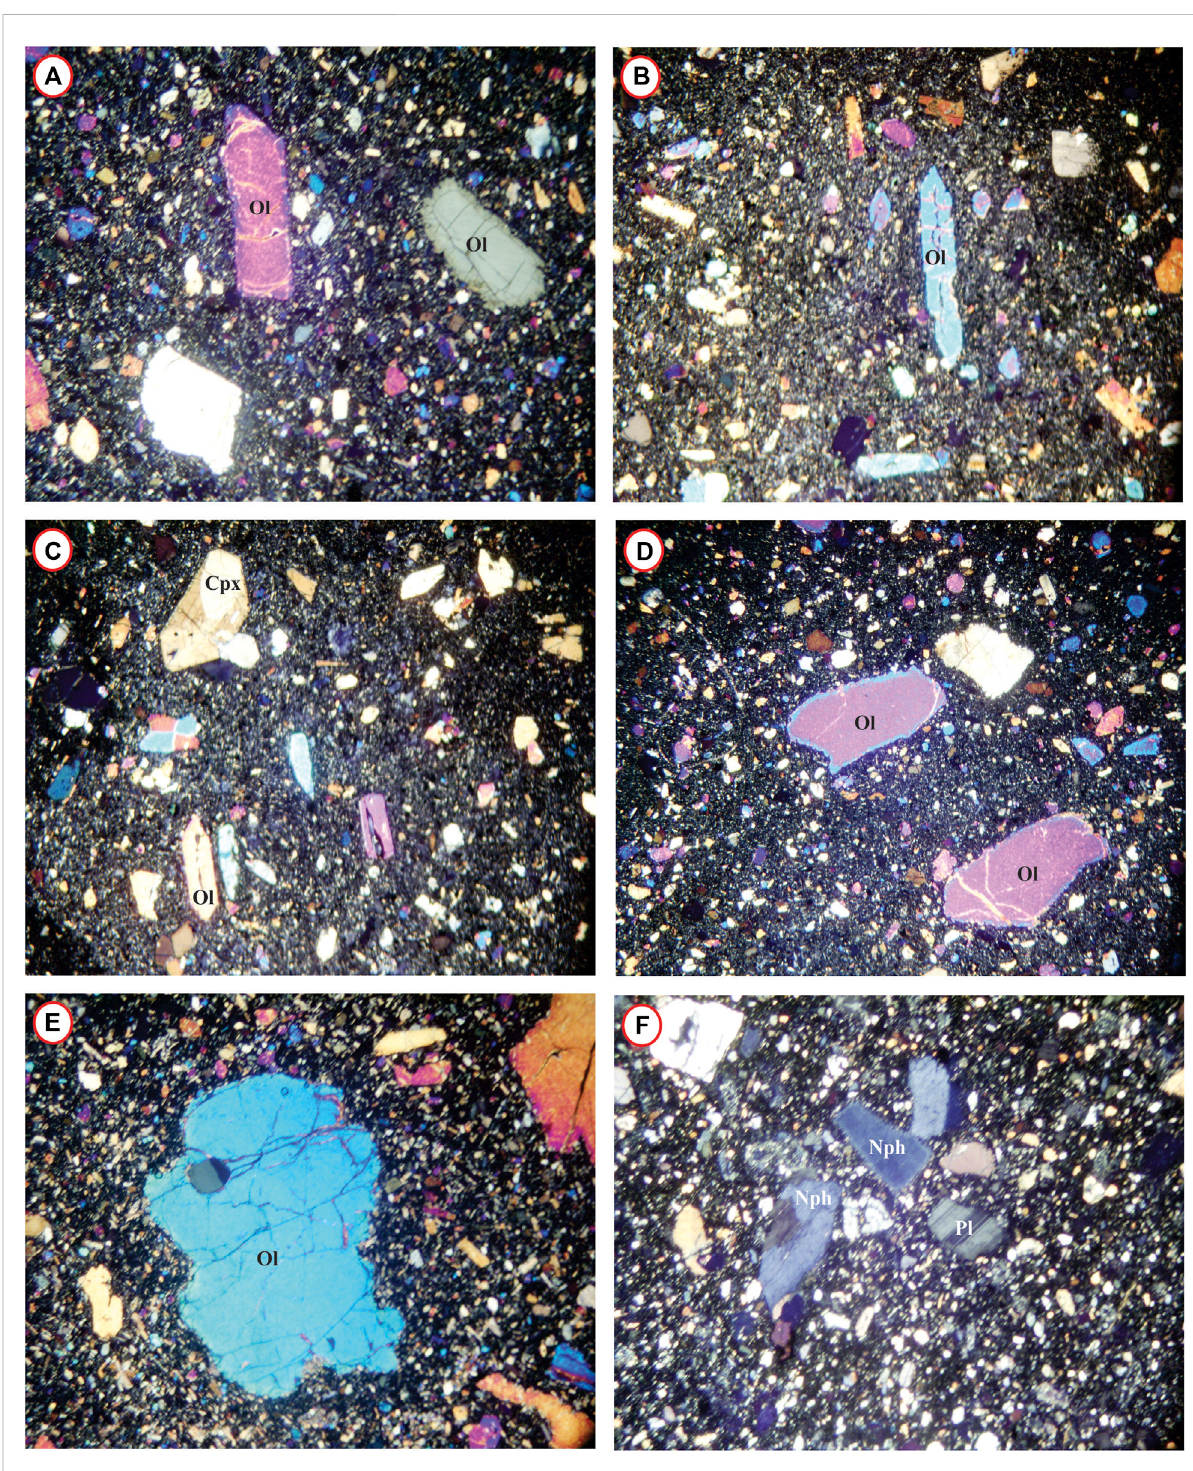
FIGURE 3 Photomicrographs of basanites showing the main petrographic features. (A) Prismatic euhedral olivine phenocryst with characteristic porphyritic texture; (B) seriate texture showing a range of crystal sizes. Note the elongated skeletal olivine in the center, and (C) sector zoning in clinopyroxene. Note the six-sided euhedral olivine phenocryst with prism and dome faces on the left side; (D) sub-rounded olivine xenocrysts. Few rounded olivine microphenocrysts are also present on the top. Note the compositional zoning in xenocrysts with sawtooth edges; (E) anhedral olivine xenocryst; (F) plagioclase microphenocryst with characteristic polysynthetic twinning surrounded by nepheline microphenocrysts. Abbreviations: Ol, olivine; Pl, plagioclase; Cpx, clinopyroxene; Nph, nepheline. Magni fi cation ×50,